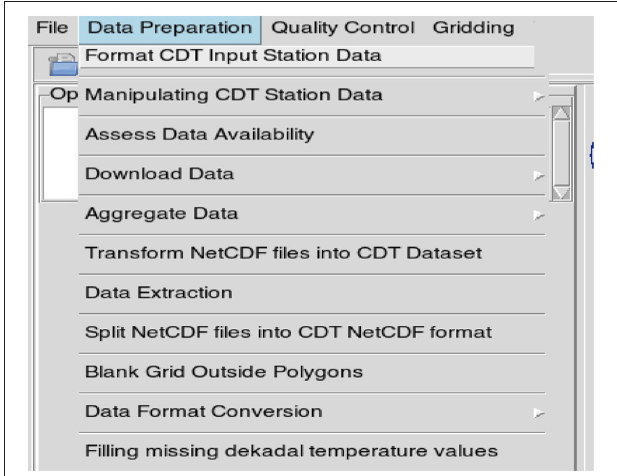
FIGURE 3 | CDT data preparation